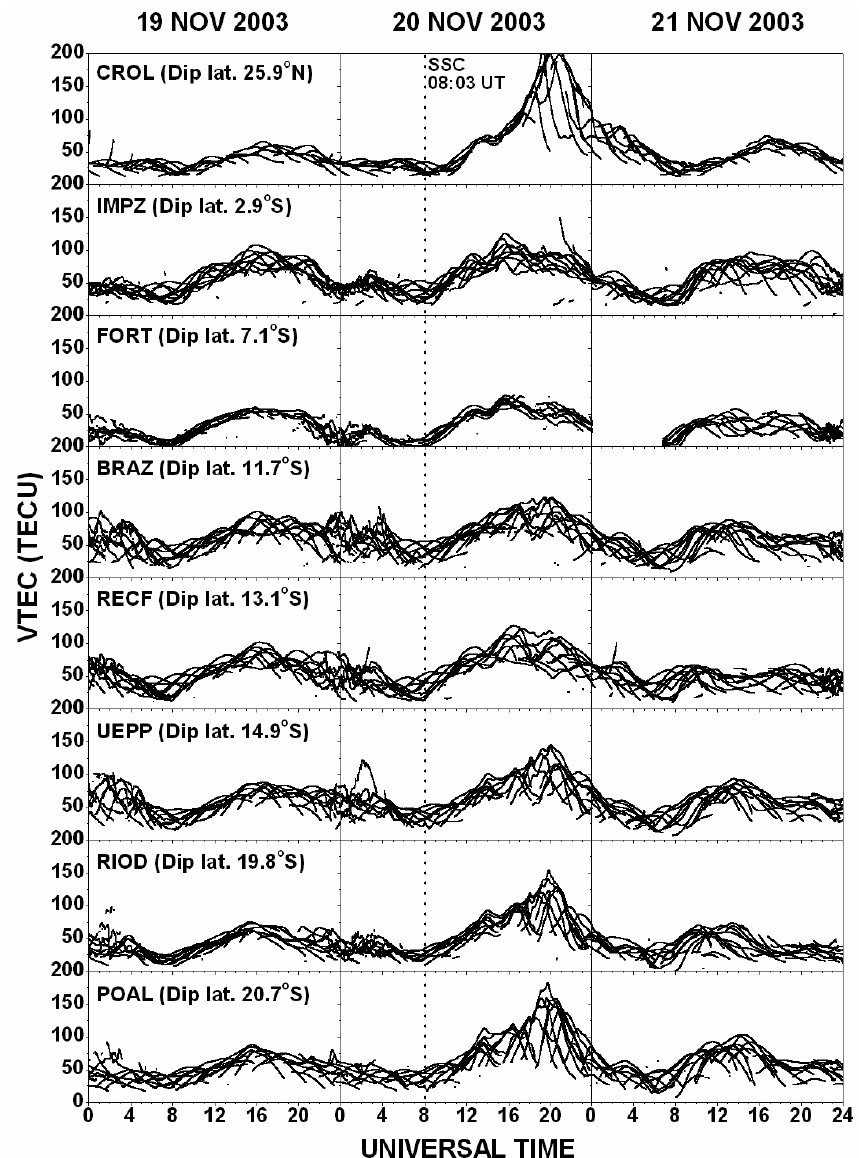
Fig. 7. The vertical total electron content (VTEC) variations from GPS observations (satellites above 30 ◦ elevation angle) at 8 receiving stations (Table 1) during the period 19 to 21 November